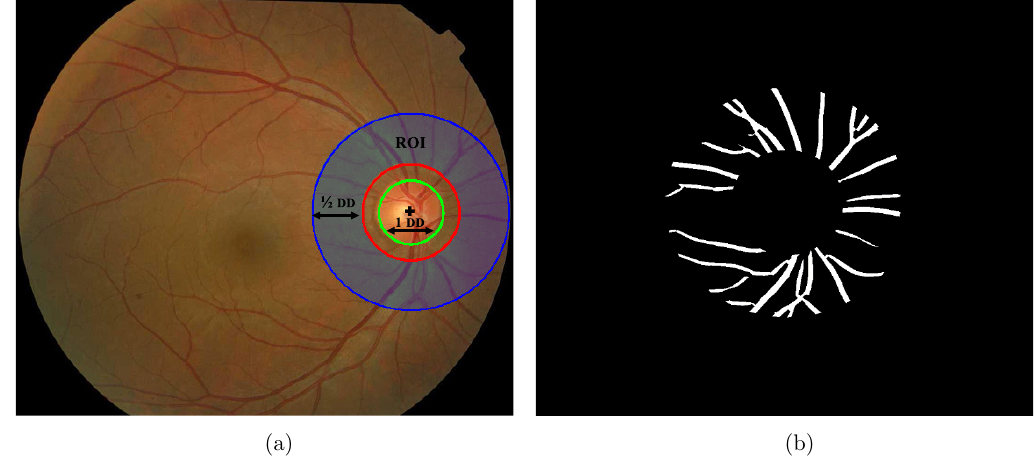
Fig. 7. OD boundary. (a) OD boundary marked in green color and RoI is shown between concentric red and blue circle and (b) Retinal vessels segments inside